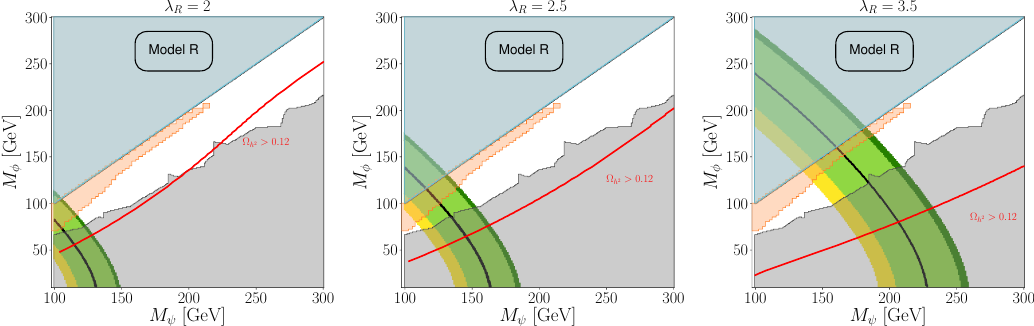
Figure 7. Results from Model R, scanning over the masses of the new fermion and scalar which couple to the right-handed muon. Colours are the same as figure 5.